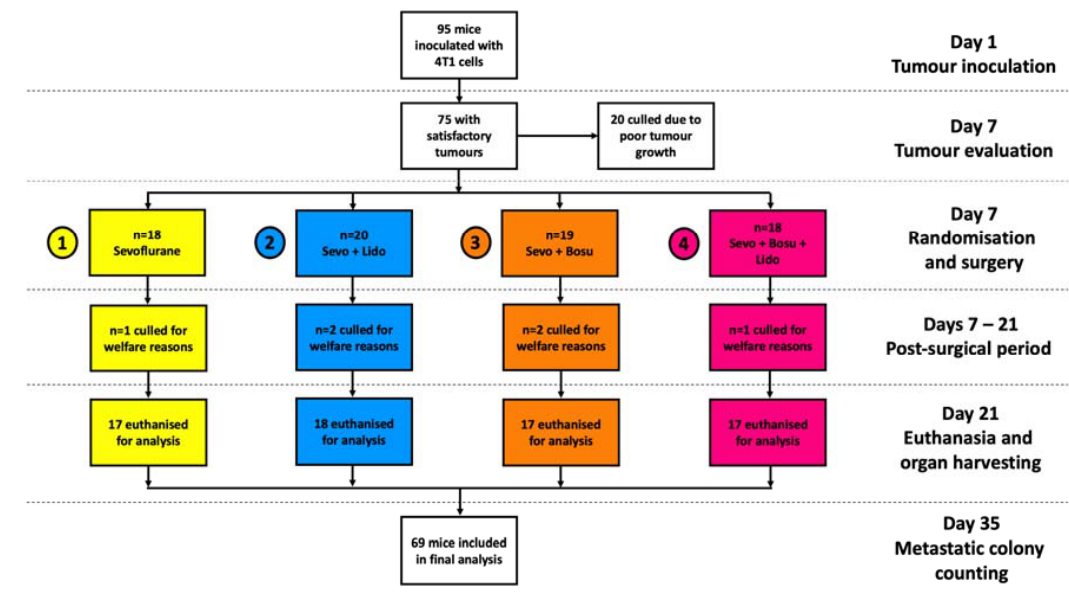
Figure 1. Flow diagram of in vivo experimental protocol and animal numbers. On day 1 of experiment, 4T1 breast cancer cells were inoculated into the mammary fat pad of female BALB/c mice ( n = 95). After 7 days, mice with palpable tumours ( n = 75) underwent tumour excision under sevoflurane anaesthesia, plus randomised perioperative drug treatment. Group 1 received